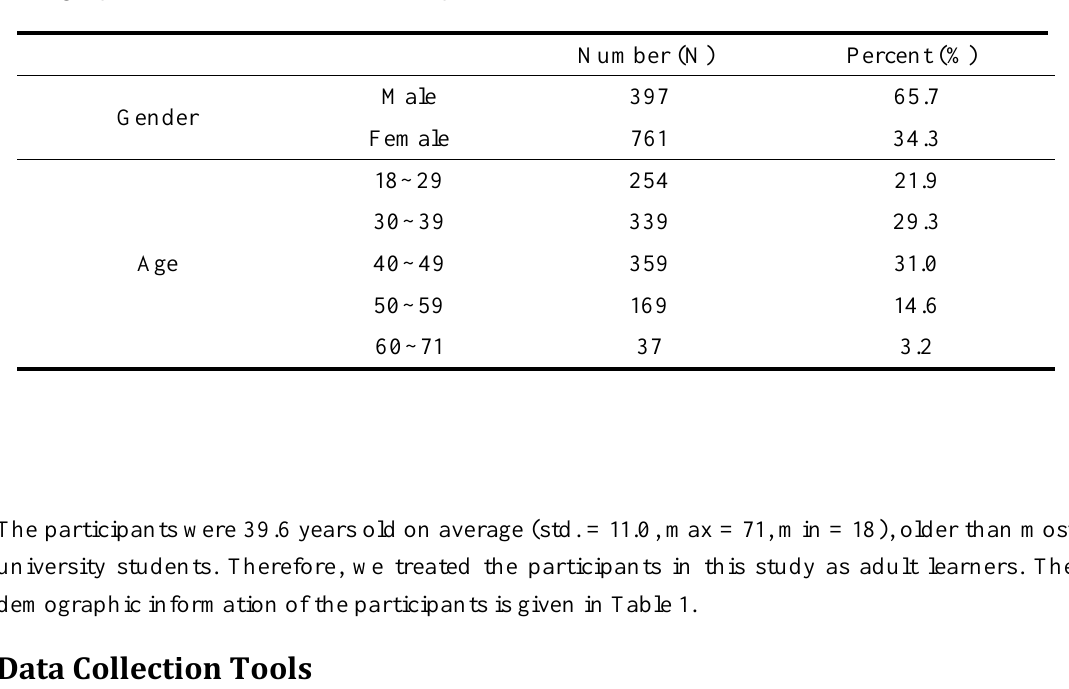
Demographic Information of the